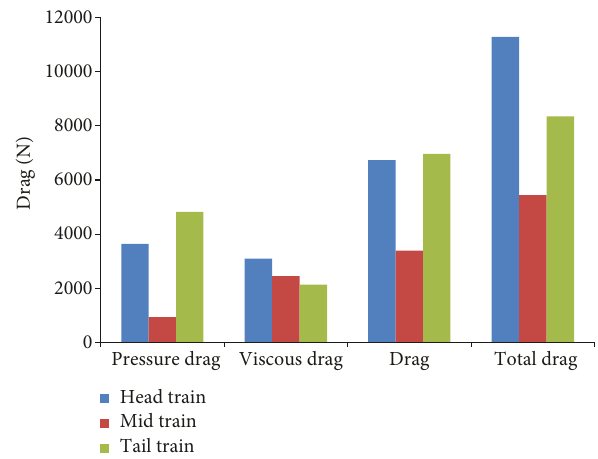
Figure 12: Aerodynamic drag of bionic model of high-speed